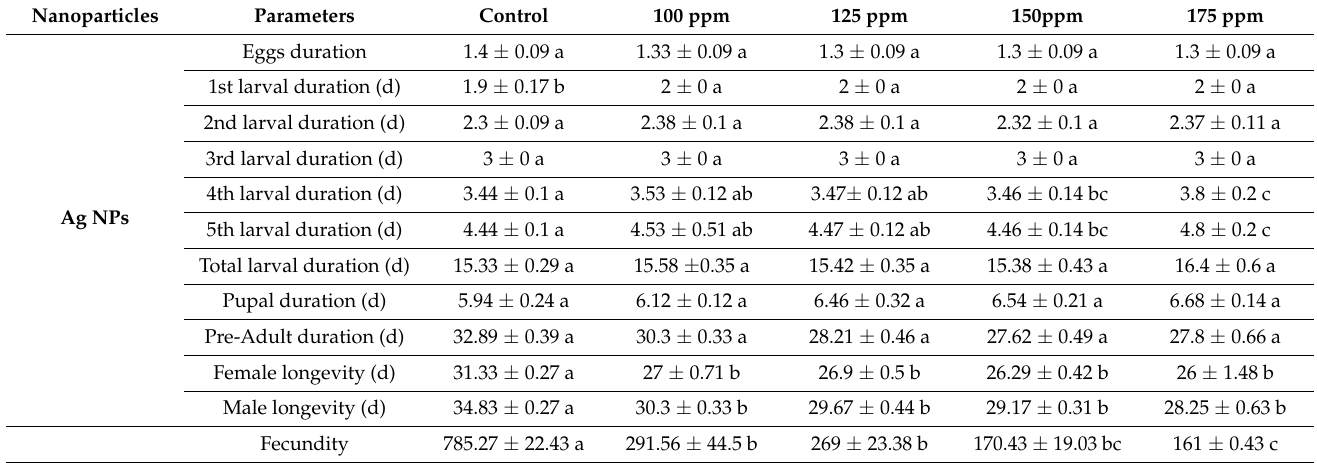
Table 2. Effects of Ag NPs on biology of H. armigera .